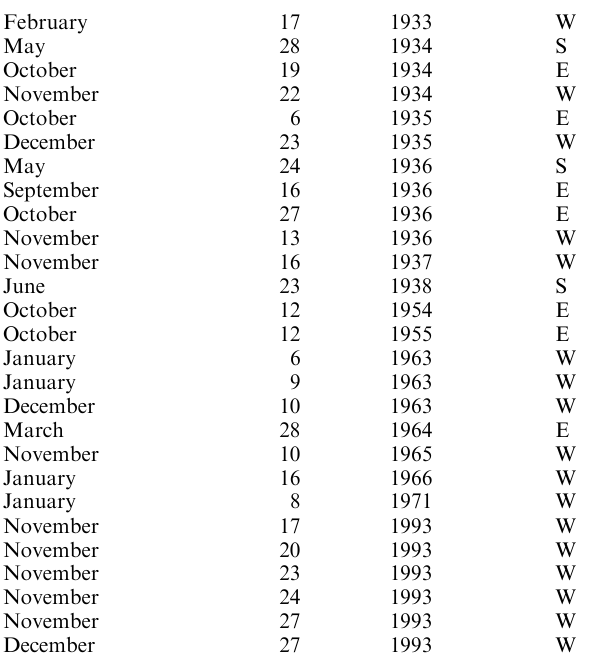
Table 2. Days with Ap = 0 in the period